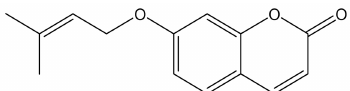
Figure 1. Structure of 7-isopentenyloxycoumarin.